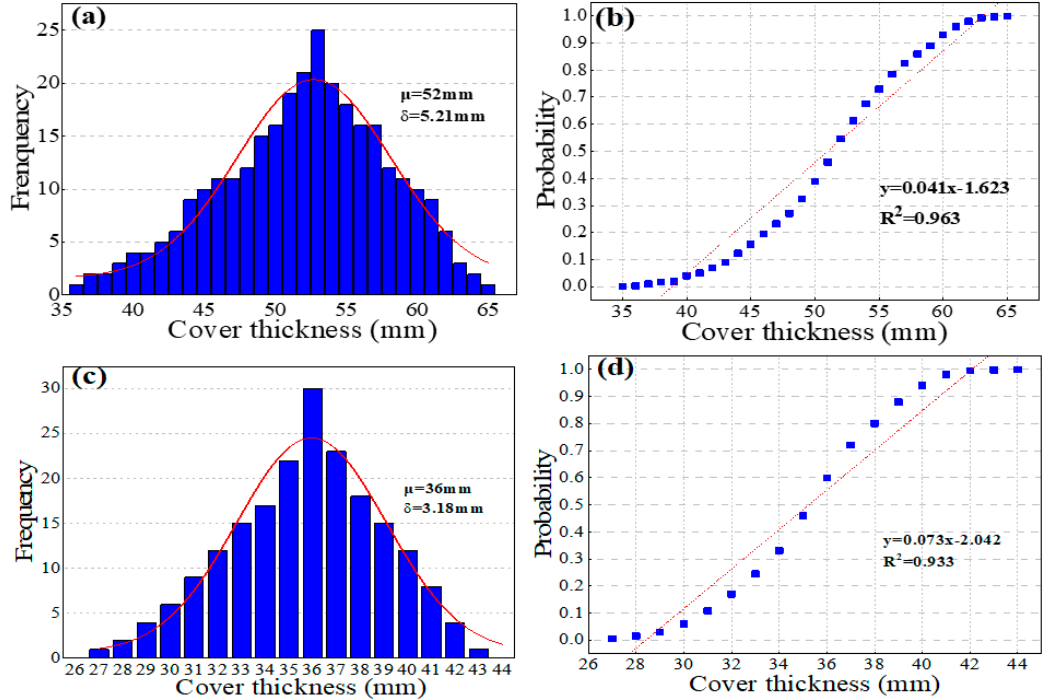
Figure 3. Concrete cover thickness of piers in the marine section and the land section. ( a ) Frequency (marine section); ( b ) Probability (marine section); ( c ) Frequency (land section); ( d ) Probability (land section).